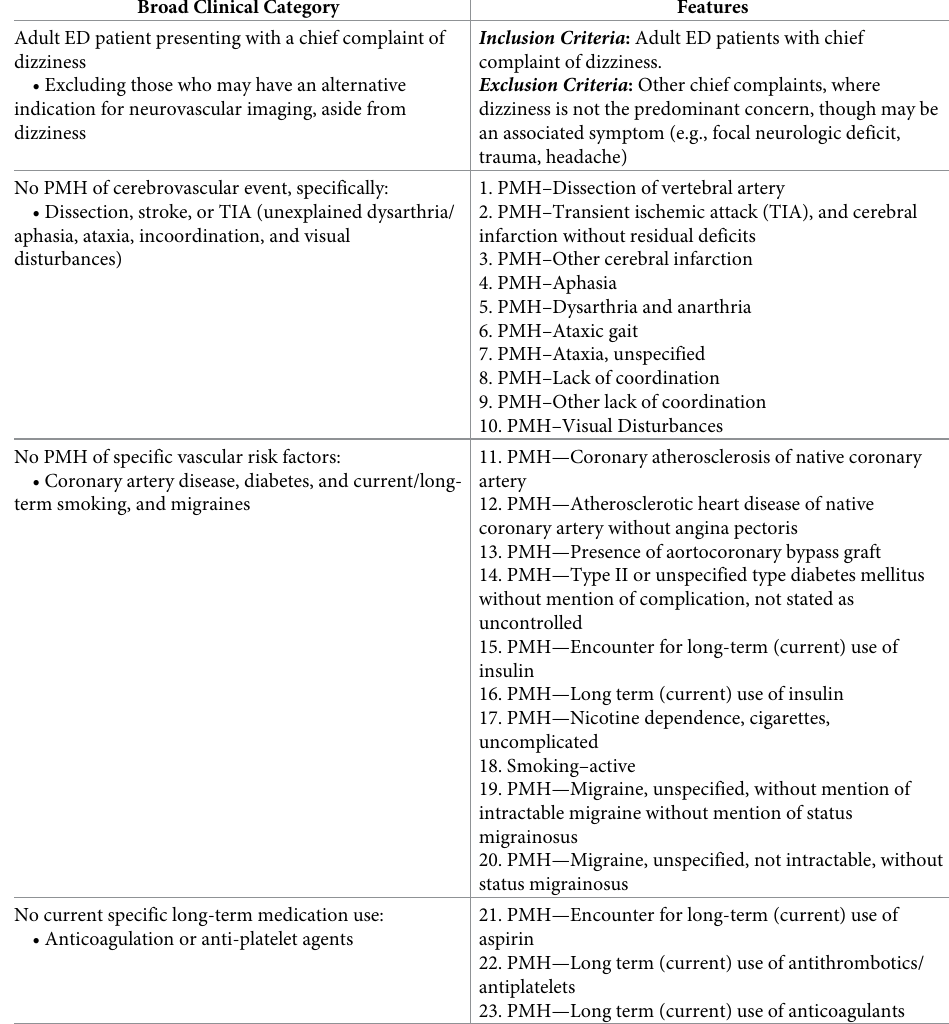
Table 2. List of features, summarized into clinical